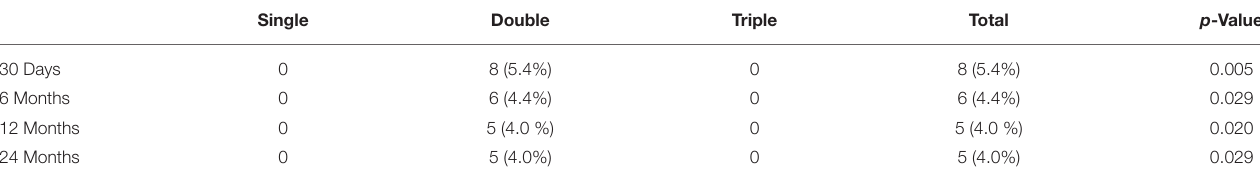
TABLE 6 | Relationship between branching number and reinterventions.